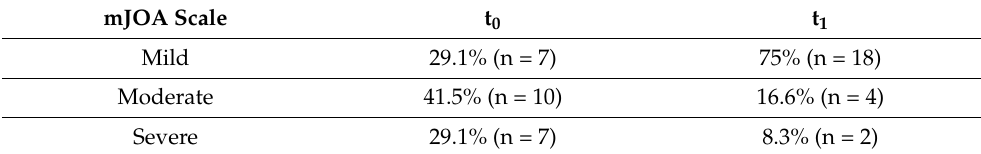
Table 2. Distribution of patients according to their mJOA mean scores at t 0 and t 1 .